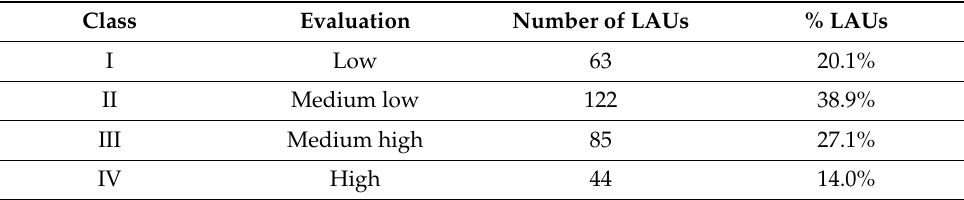
Table 5. Classification of Local Administrative Units (LAUs) implementing green economy principles based on indicator W ge .